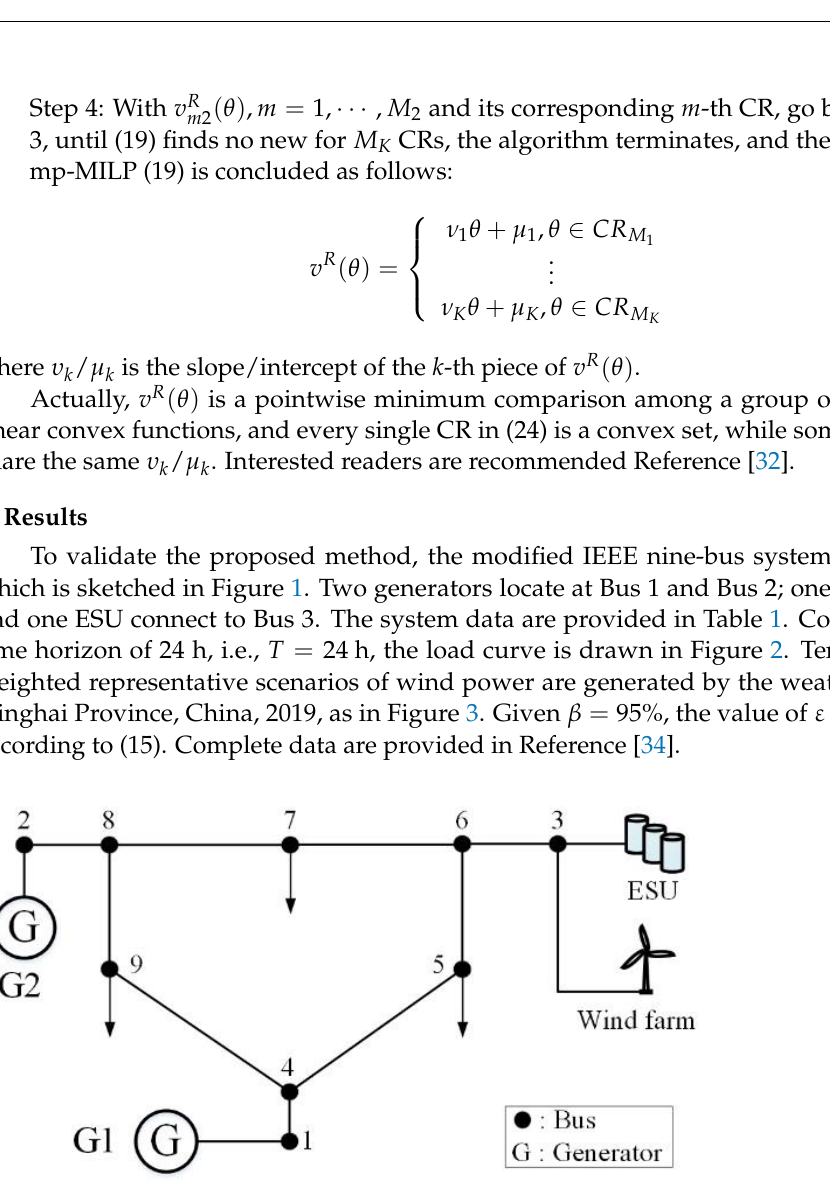
Figure 1. Sketch of the modified IEEE nine-bus system. Table 1. System data.